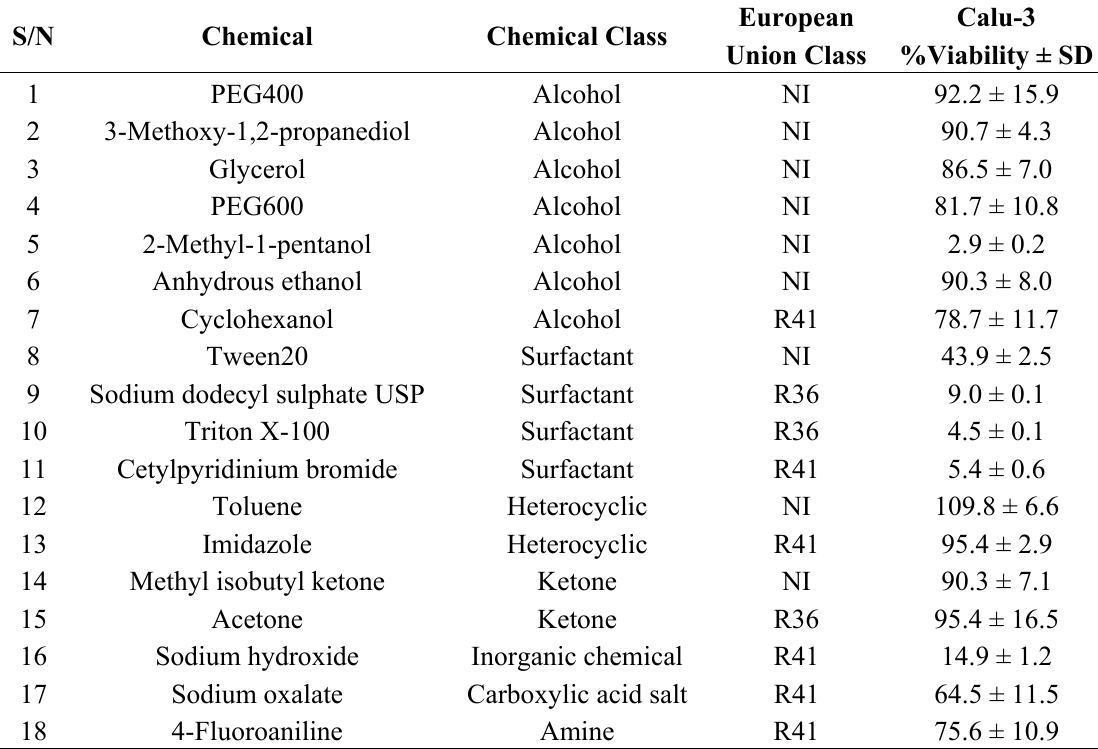
Table 3. Effect of test compounds on Calu-3 cells viability after incubation with 1.0% test solutions for 60